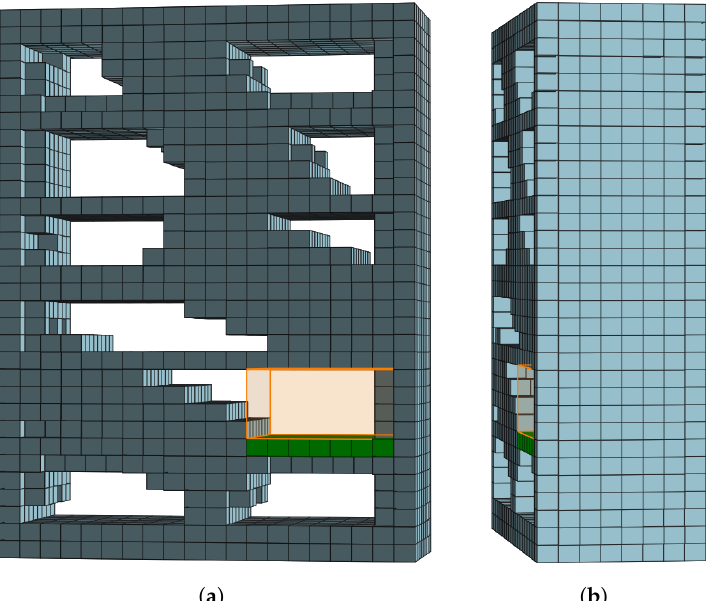
Figure 4. Detected storage surface (green voxels) of a FSC from Figure 3 and its corresponding storage volume (orange bounding box): ( a ) Front view, ( b ) Side view.